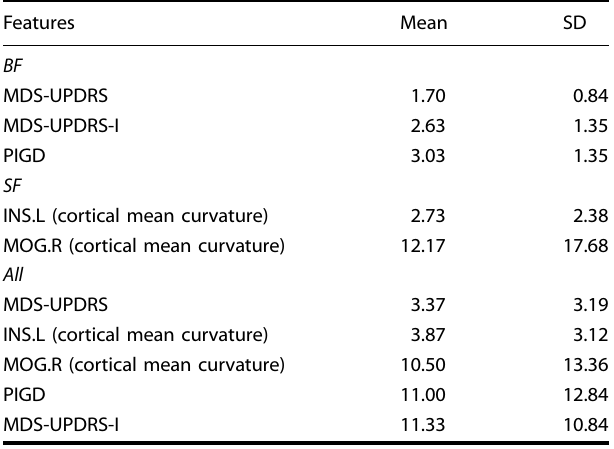
Table 3. The results of feature selection based on generalized Fisher score using different